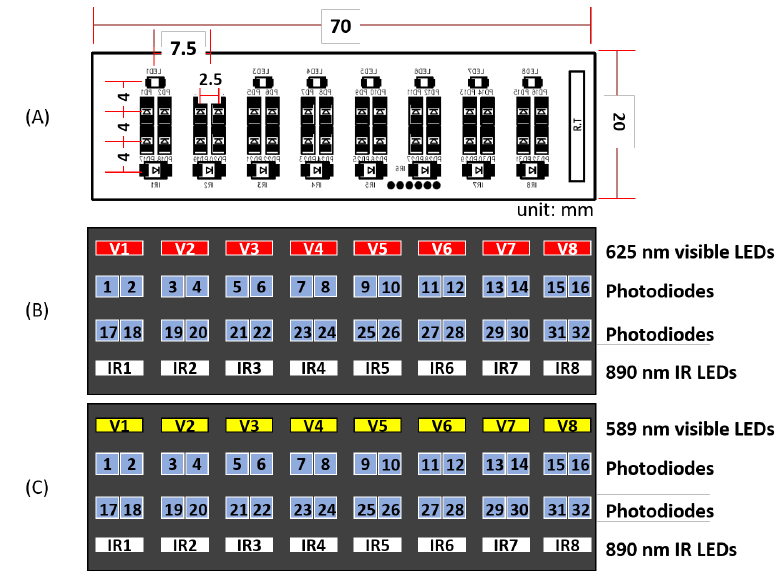
Figure 6. ( A ) The layout of LED arrays in an MSP module; ( B ) an MSP module equipped with eight red light LEDs and eight infrared light LEDs; and ( C ) an MSP module equipped with eight yellow LEDs and eight infrared LEDs. For both designs, 32 photodiodes (PD) are arranged between two layers of LEDs in a 2 × 16 matrix